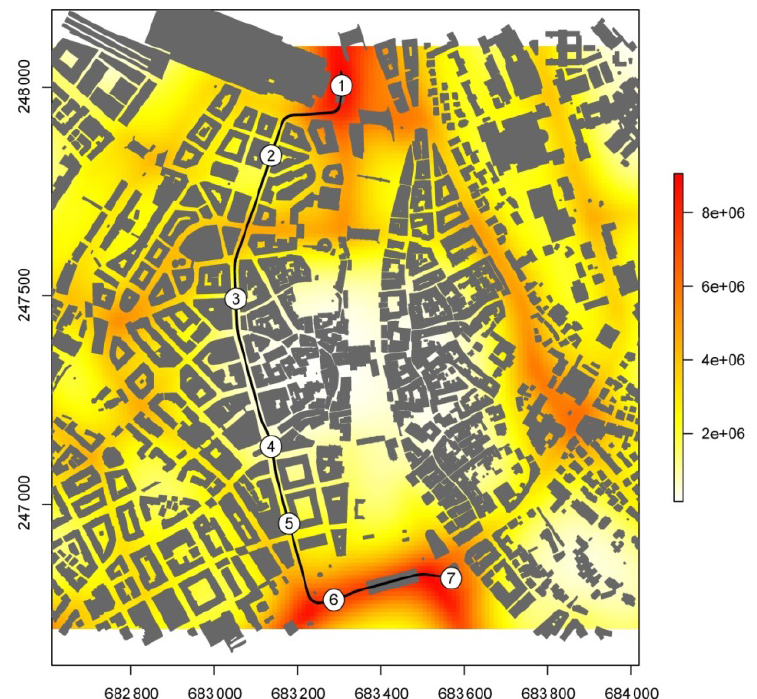
Figure 10. Traffic intensity map. The tram track of line 11 between the stations Bahnhofquai (1) and Bellevue (7) is indicated by the black